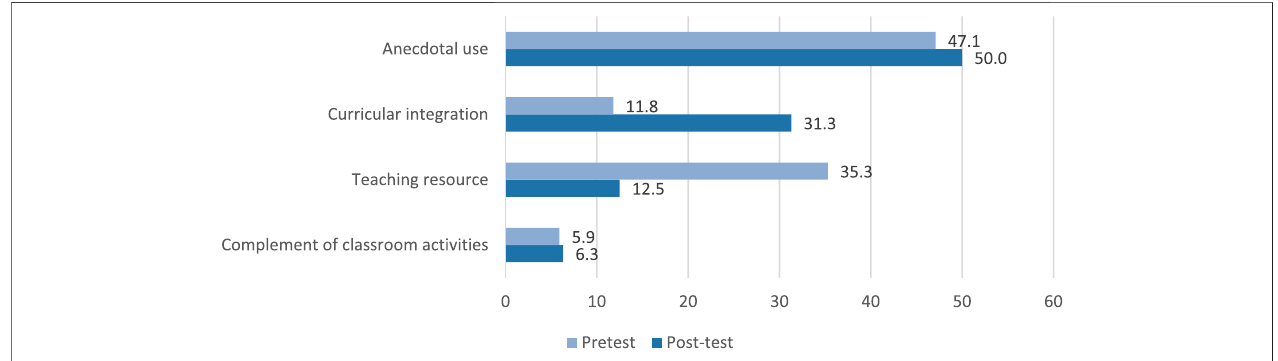
FIGURE 4 | What presence does the Way of St. James have in the primary education curriculum.